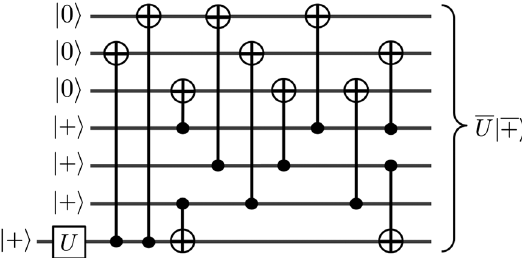
FIG. 8. The non-fault-tolerant circuit, based off the design in Ref. [37], for encoding a single-qubit state into the 7-qubit code. Pushing state preparations as far right as possible, we find that this construction has circuit volume 34. To make j CCZ i (assum- ing no faults), we can use three such circuits on three physical qubits in the state j CCZ i ¼ CCZ jþi ⊗ 3 .